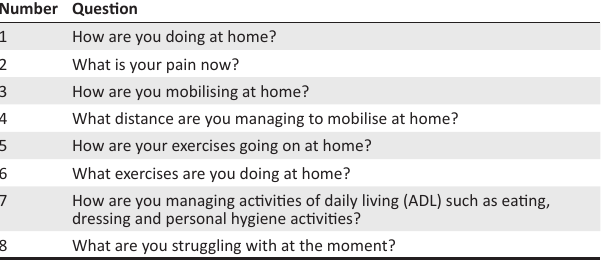
TABLE 1: Assessment